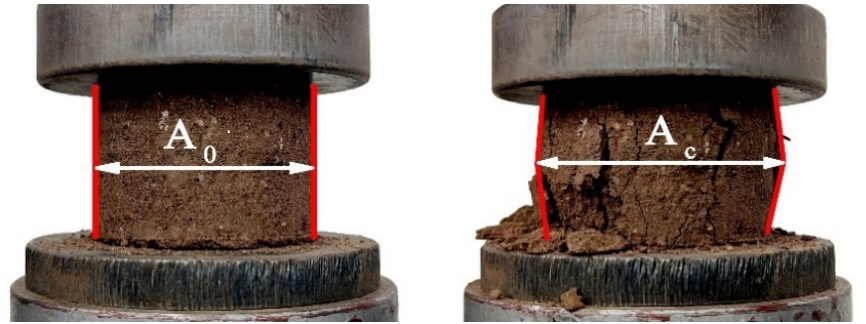
Figure 5. Comparison of cross-sectional area before and after compression.